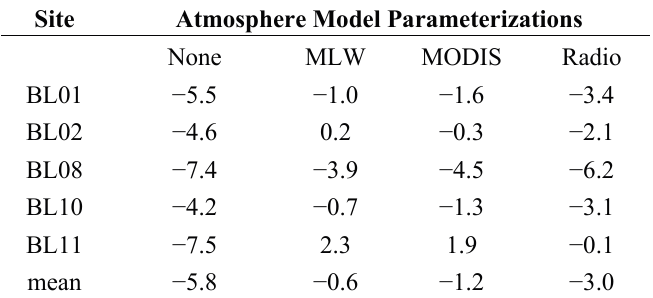
Table 4. Temperature differences between the measured and computed values at the five locations where ground surveys were performed. The comparison was made with temperatures computed using different sets of parameters for the radiative transfer model (mid-latitude winter, MODIS data, radiosonde profile; see Section 3.2 for details). Furthermore, the differences between measured and apparent temperatures are reported in the first column for